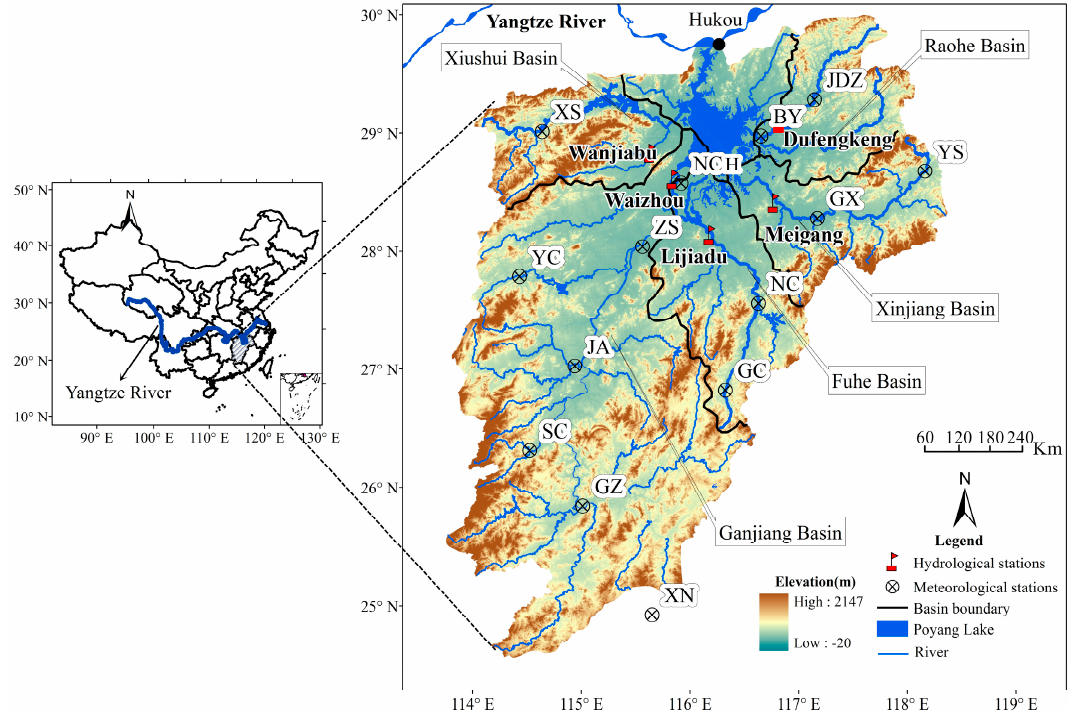
Figure 1. Location of the Poyang Lake Basin and the distribution of hydrological stations and